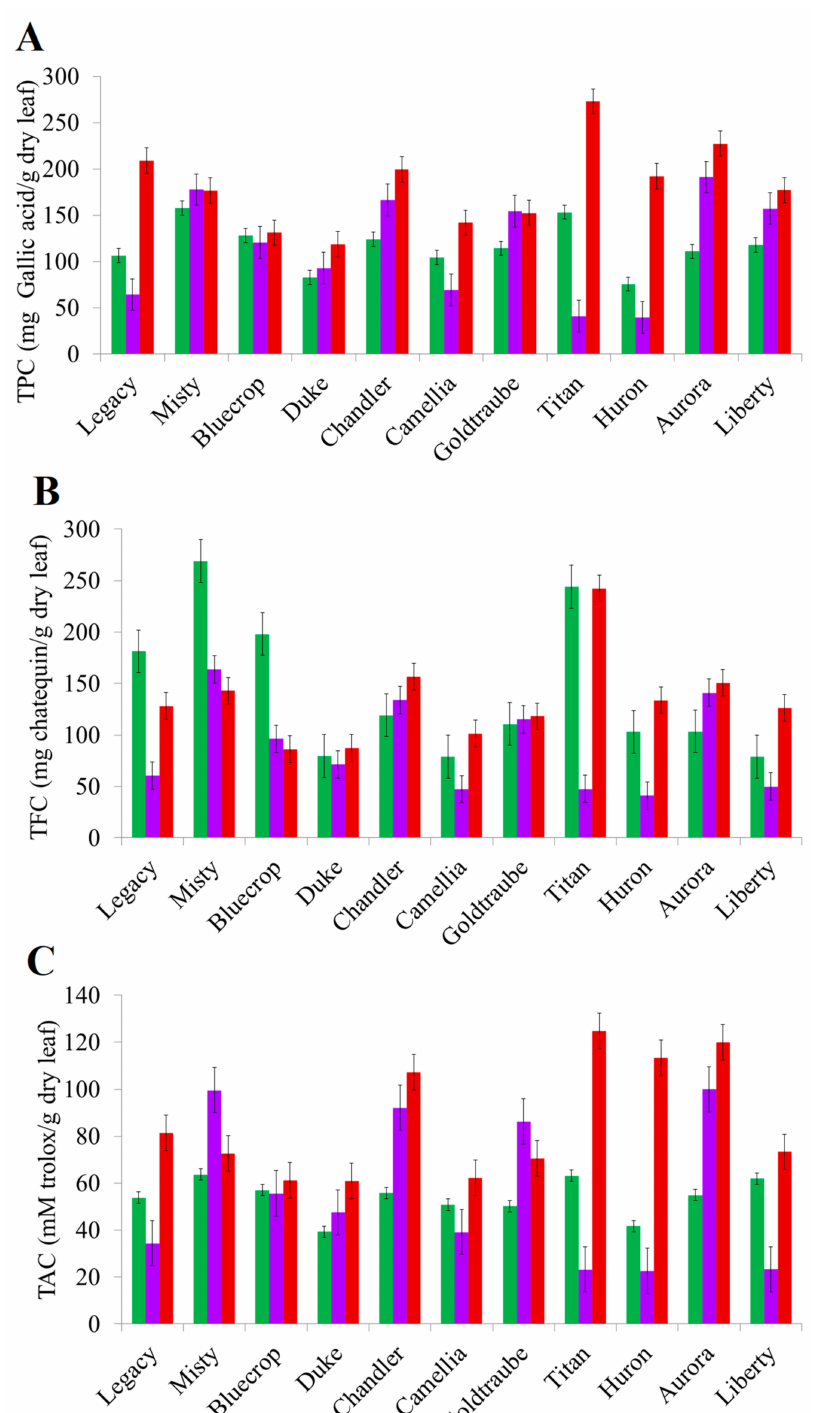
Figure 1. Total Phenolic Content ( A ); Total Flavonoid Content ( B ) and Total Antioxidant Capacity ( C ) of the hydroalcoholic extracts from cultivars collected in the three considered seasons of the year. Legend: █ May; █ September; █ December.